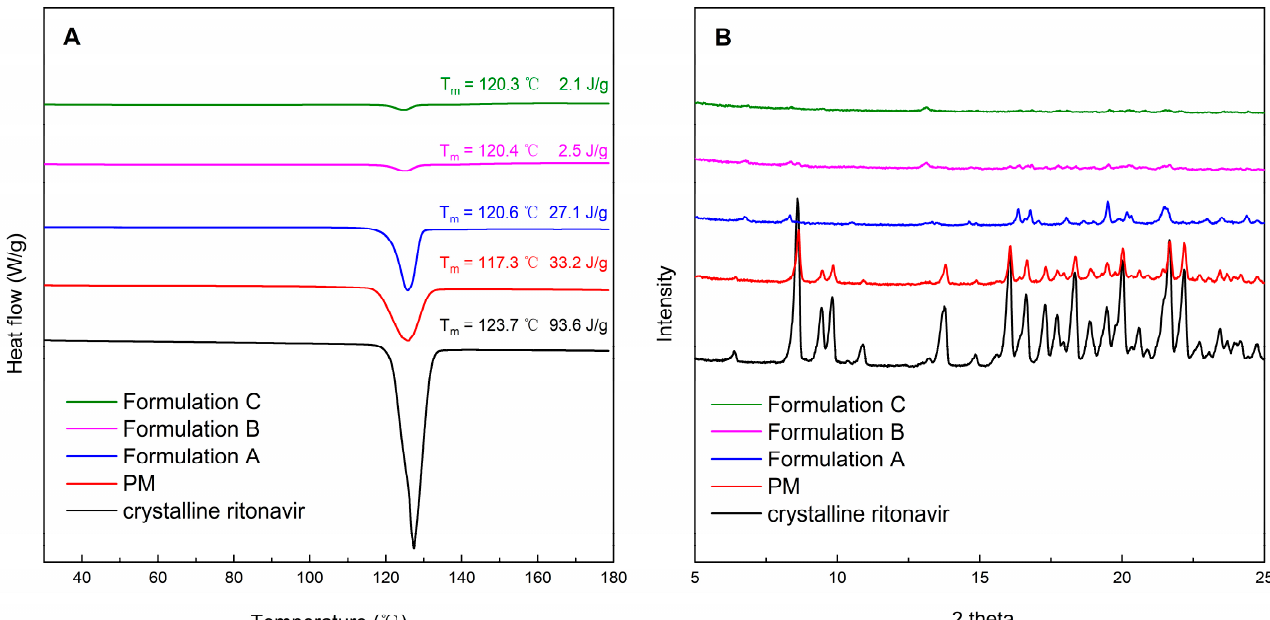
Figure 5. The DSC ( A ) and PXRD ( B ) of crystalline ritonavir, physical mixtures of ri- tonavir/PVPVA/Span 20 (PM) and precipitates of Formulation A, Formulation B, and Formulation